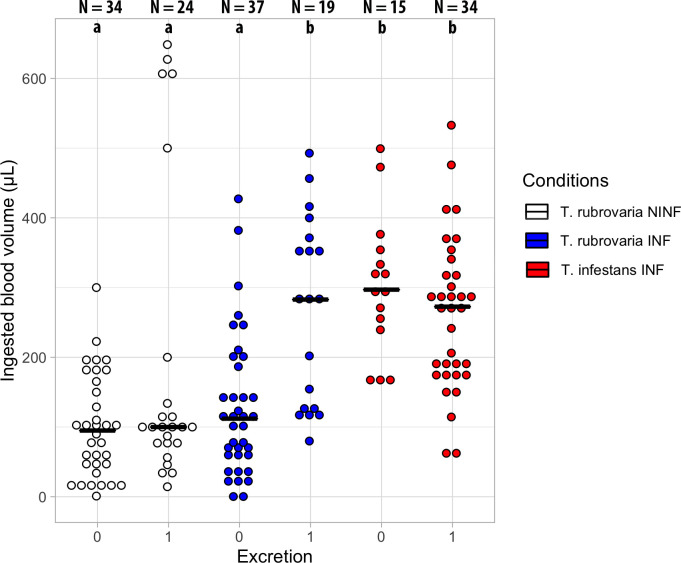
Ingested blood volume and excretion status (0: Not excreted, 1: Excreted) of non-infected T. rubrovaria (NINF), and infected- T. rubrovaria (INF) and T. infestans (INF).The number of samples analyzed for each condition is shown above each dotplot column. Different lowercase letters indicate statistically significant differences (Wilcoxon-Mann-Whitney W-test < 0.001).